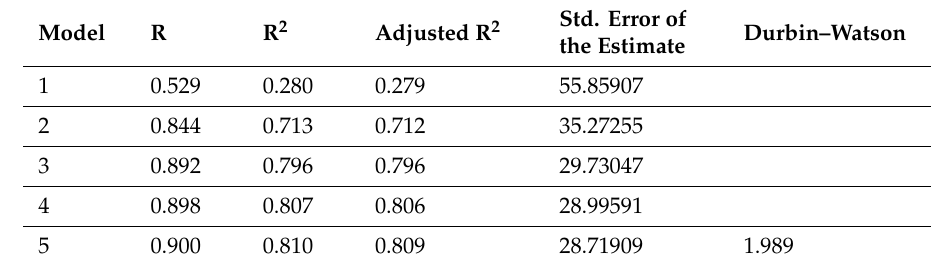
Table 6. Multiple regression analysis.